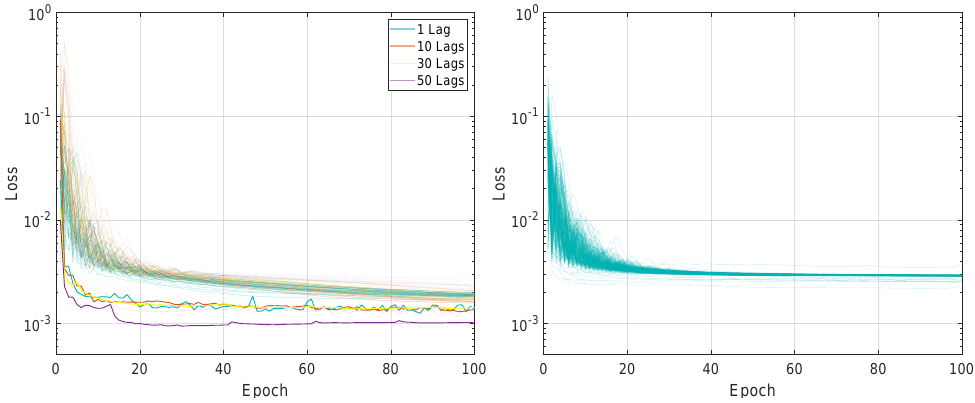
Figure 18. Illustration of the training loss for Experiment 2, LSTMTF ( left ) and VLSTM ( right ), using a many-to-many prediction